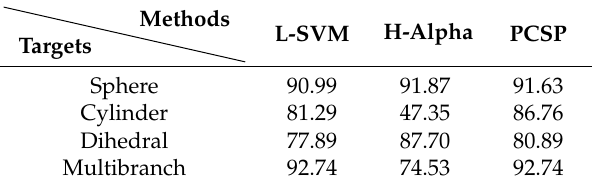
Table 7. Comparisons of operation time and RAM usage.